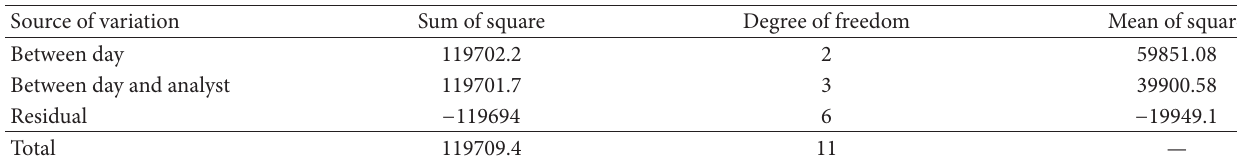
T 4: Interday precision study for